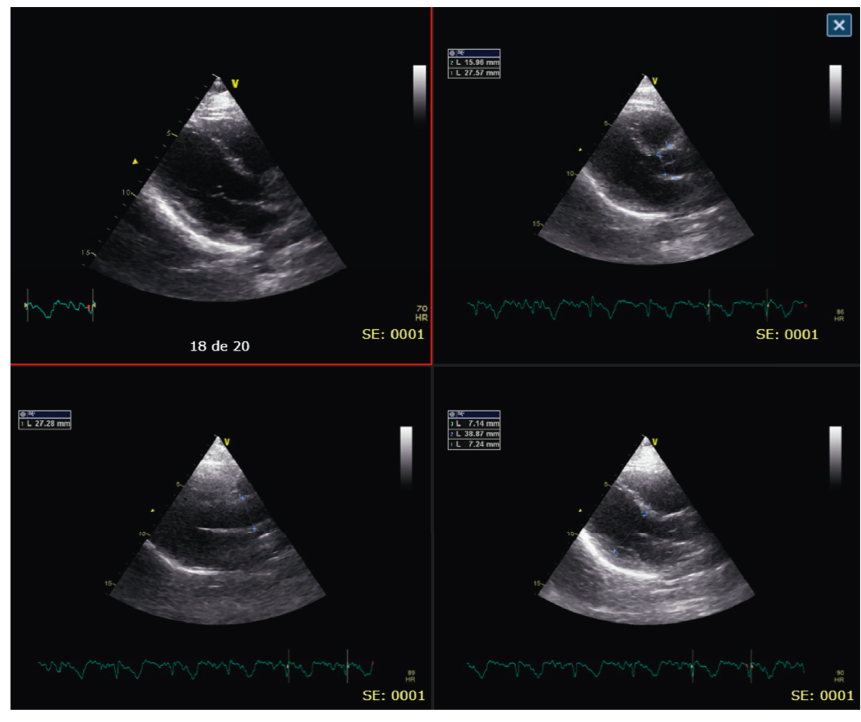
Figure 4: Transthoracic